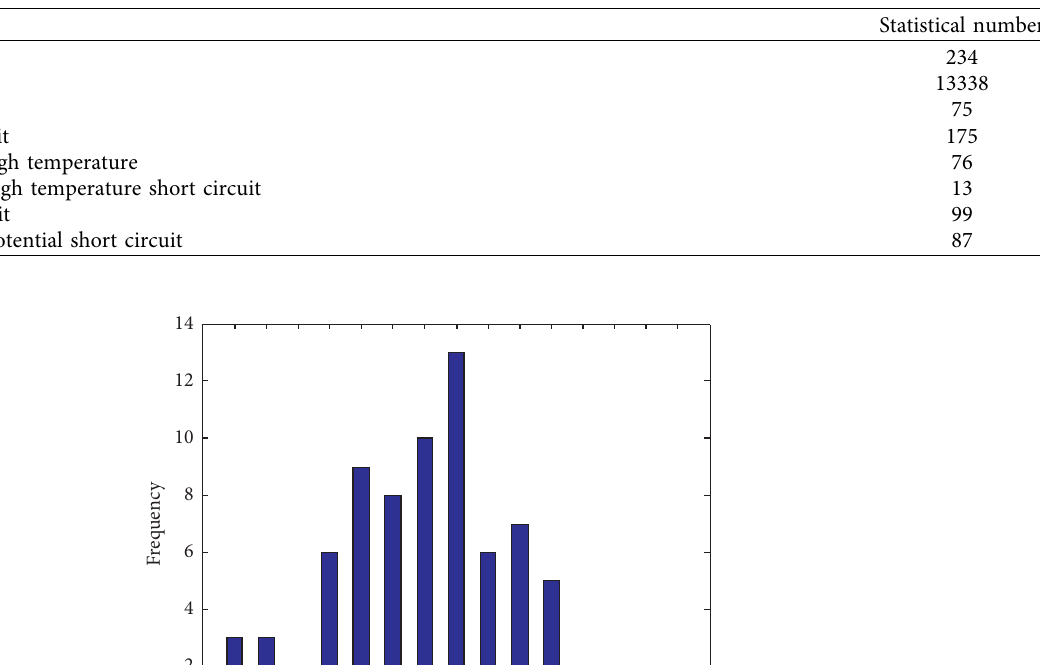
Table 5: Statistical result of the detection system.